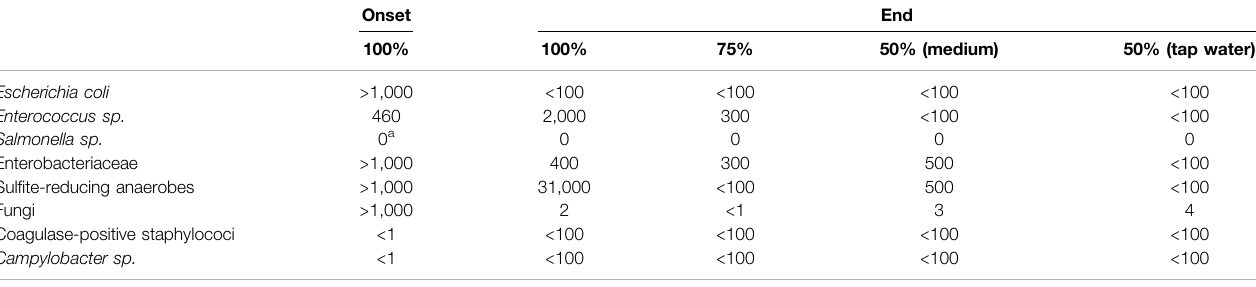
Campylobacter sp.